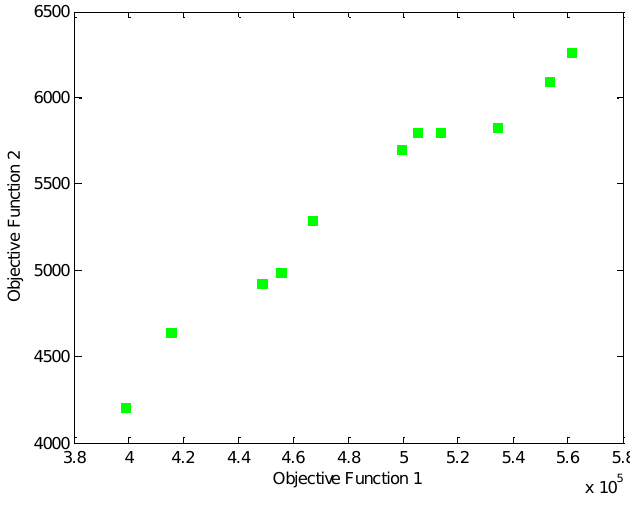
Figure 5. Pareto frontier for Scenario 2 of the